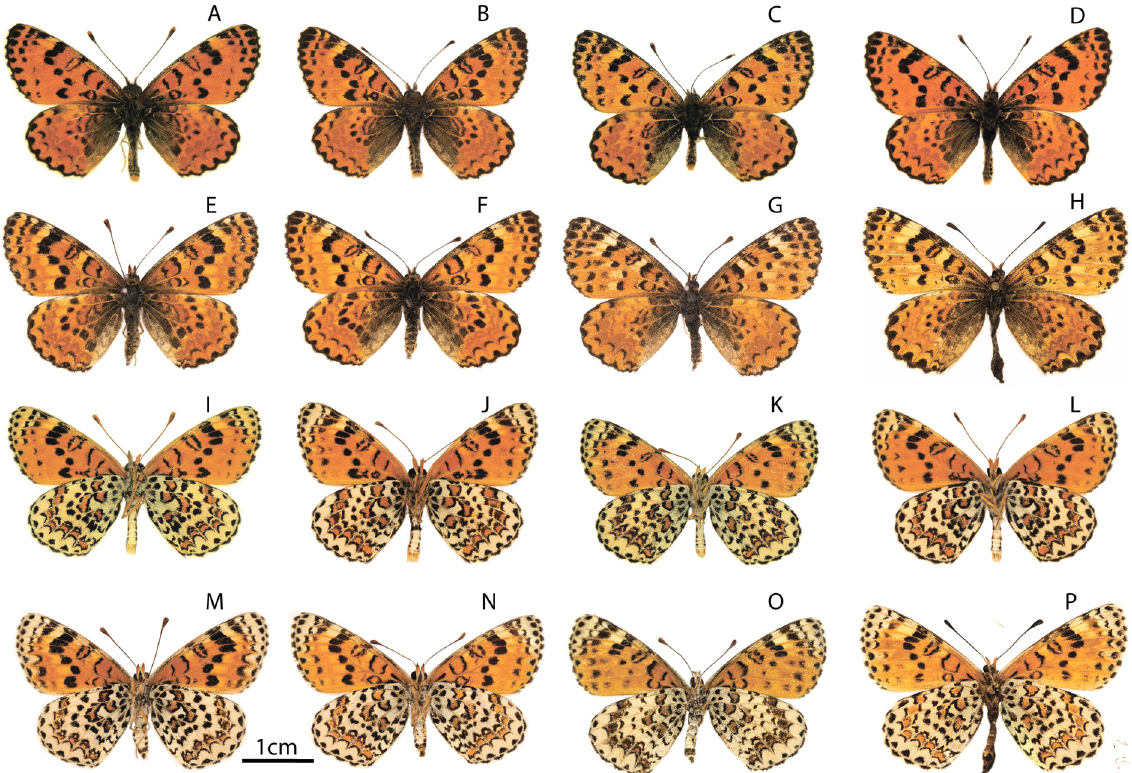
Fig. 15. Adults of Melitaea timandra binaludica subsp. nov. A – H . UPS. I – P . UNS. A, I . Holotype,